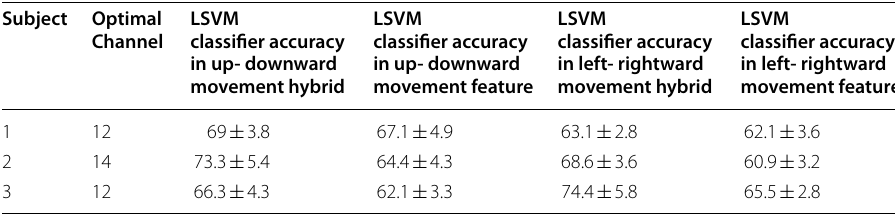
Table 3 The results of LSVM